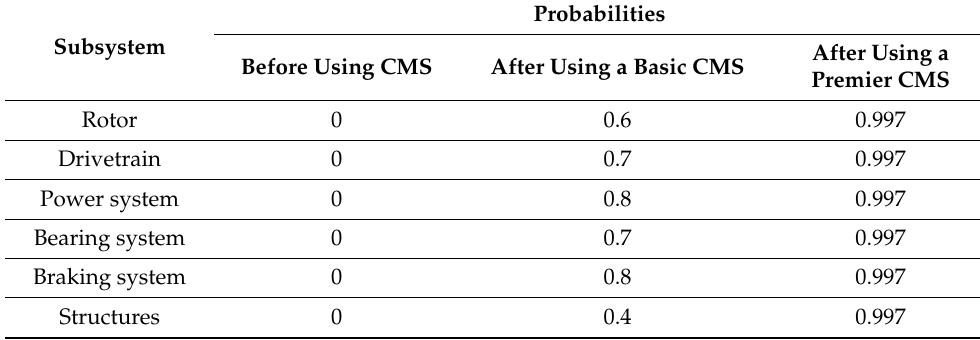
Figure 6. Detection Petri Net (DPN). Table 2. Probabilities that the faults can be detected by the condition monitoring system (CMS).